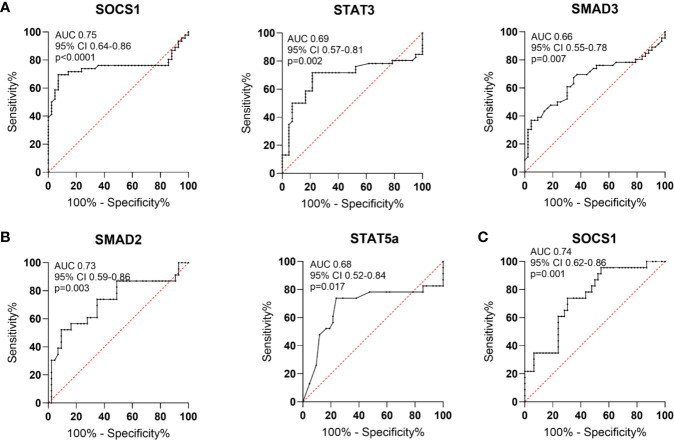
Schematic illustration of ROC curve to evaluate the diagnostic potential of AUC in whole blood (A). in RA patients and healthy subjects (B), in OA patients and healthy subjects (C), in RA patients and OA patients.